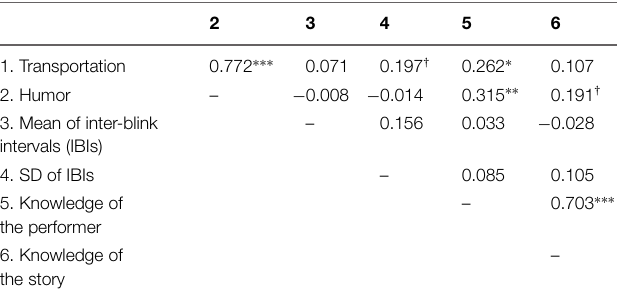
TABLE 2 | Zero-order correlation coefficients between variables used for multiple regression analysis.